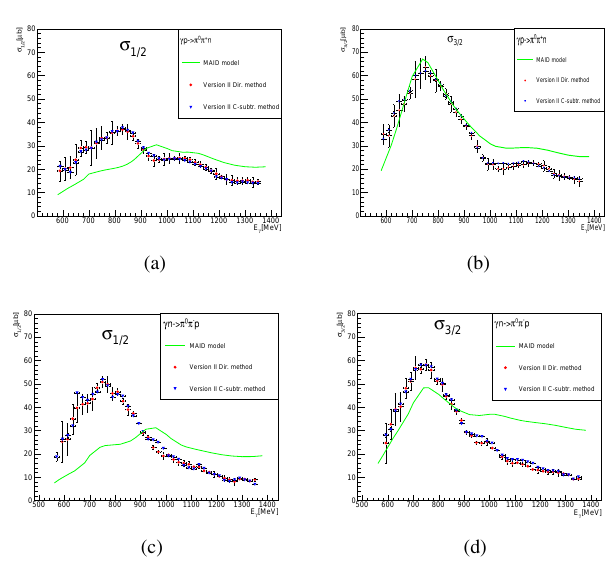
Figure 4: Total cross section comparison in terms of pho- ton energy for γ p → π 0 π + n (upper row) and γ n → π 0 π − p (bottom row). Di ff erent colored symbols in each case rep- resent the cross sections determined with the direct and carbon subtracted method with both of the aforementioned versions, and the green line shape corresponds to that pre- dicted by MAID model [10].